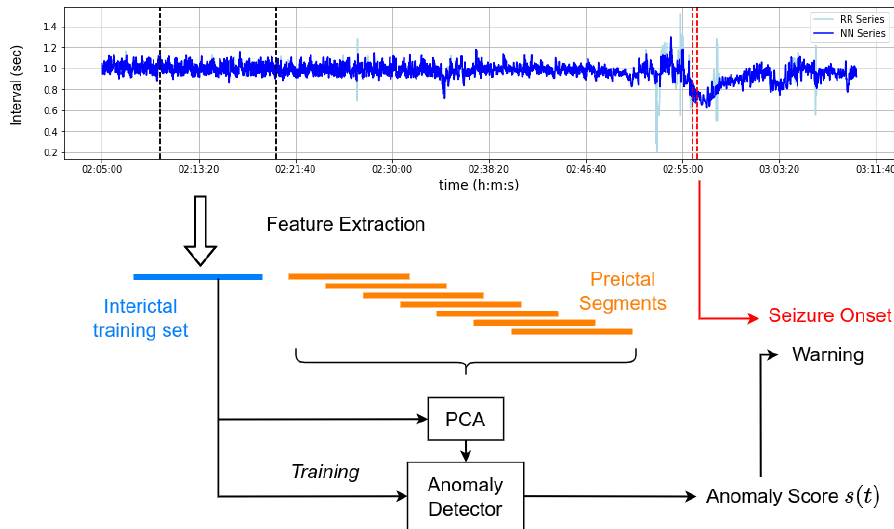
Figure 1. NN series novelty monitoring and ahead-of-time prediction scheme .